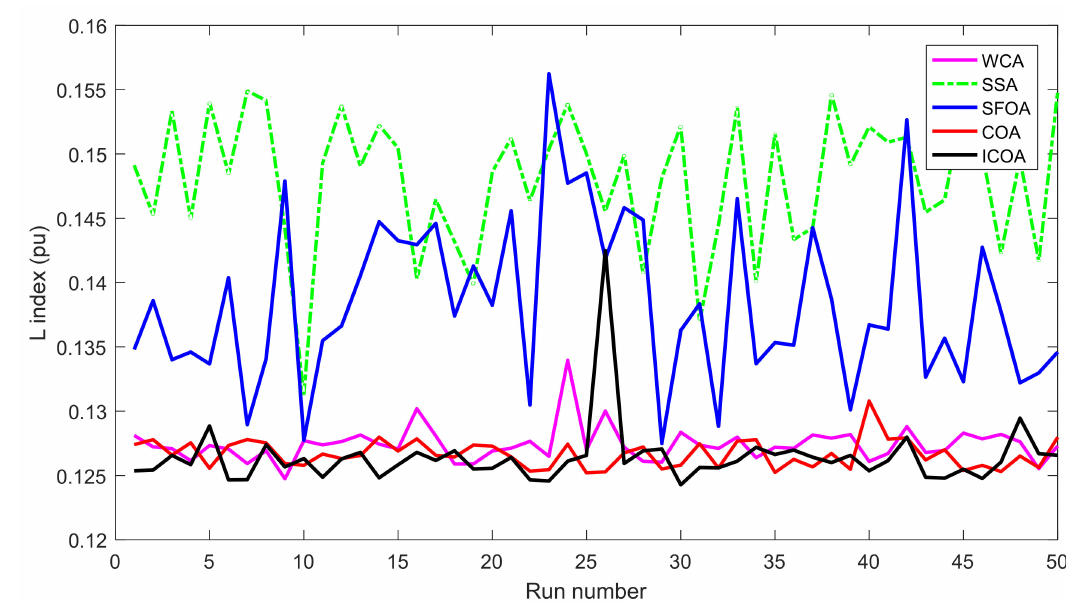
Figure 7. L index of 50 runs obtained by compared methods for the IEEE 30-bus system.